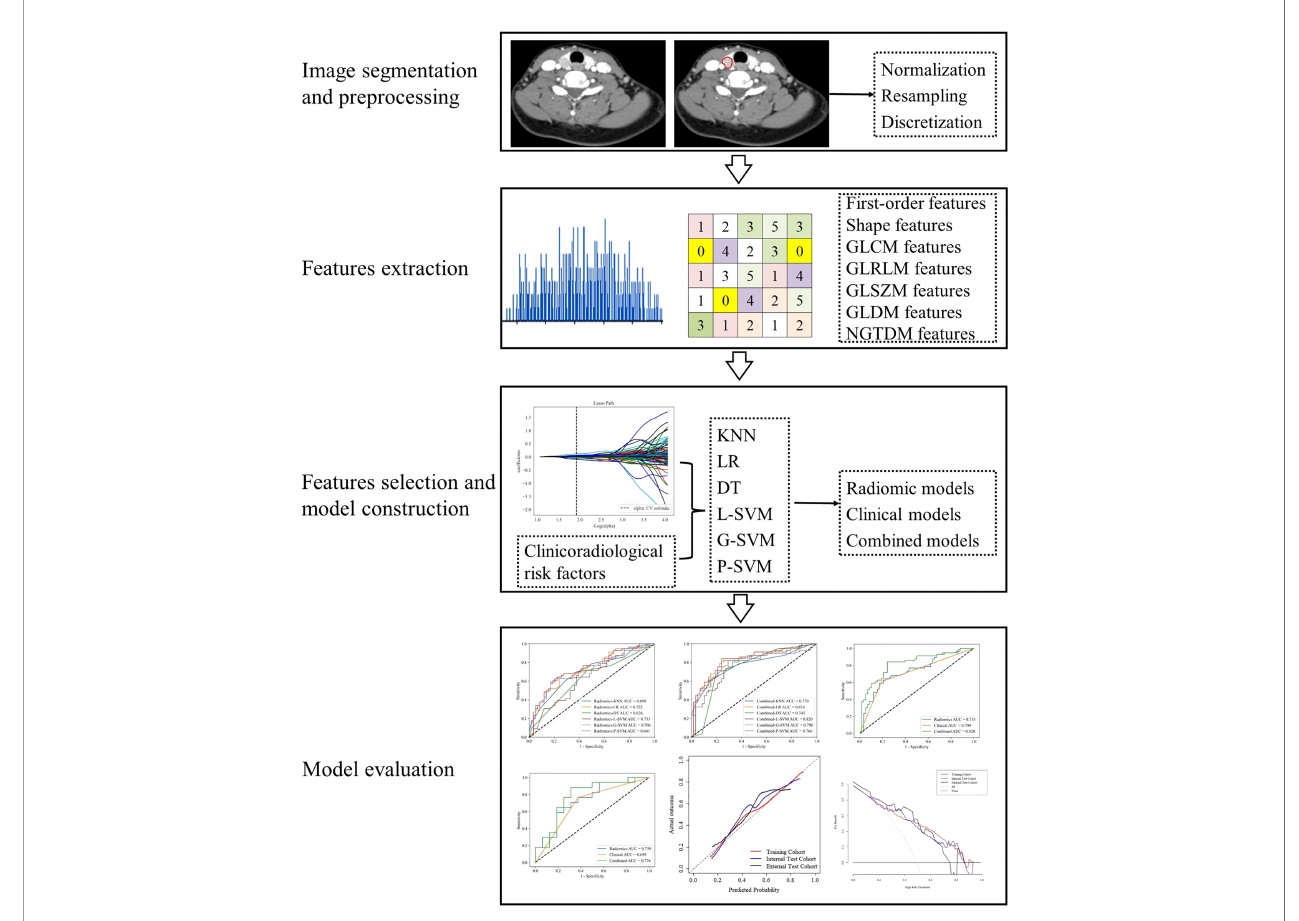
FIGURE 2 | Work fl ow of data analysis. The work fl ow illustrates image segmentation and preprocessing, radiomics features extraction and selection, models construction and